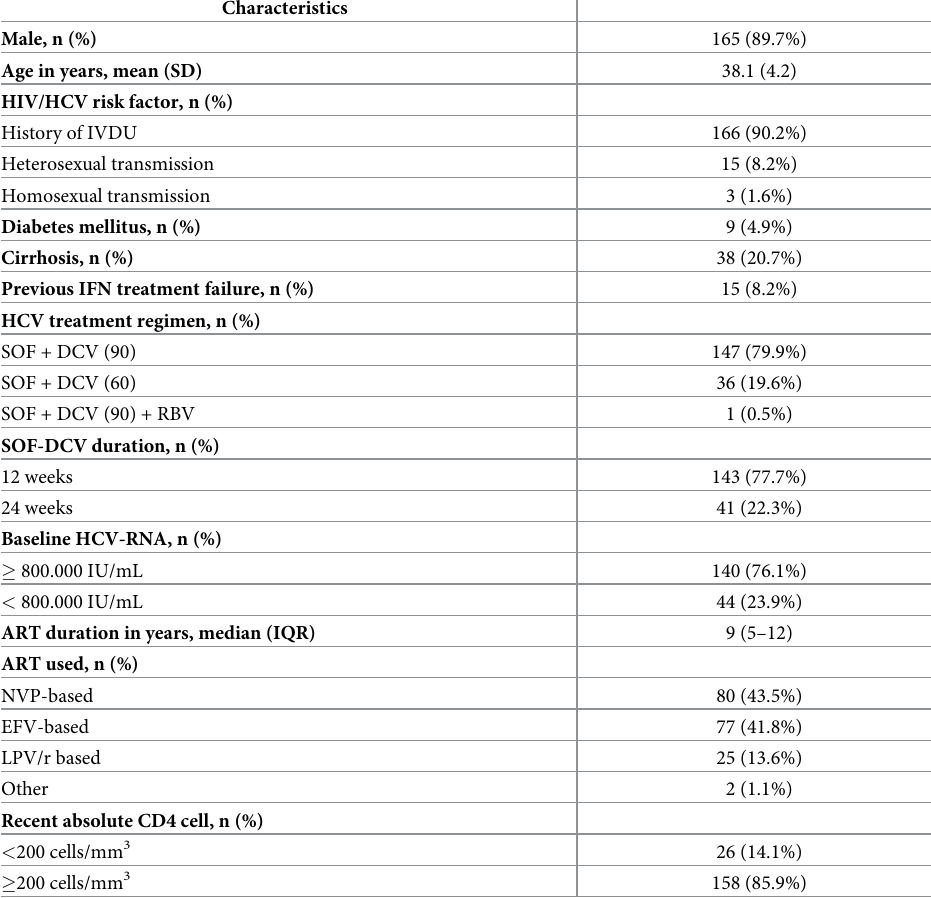
Table 1. Characteristics of patients completed sofosbuvir-daclatasvir treatment cascade (n = 184).